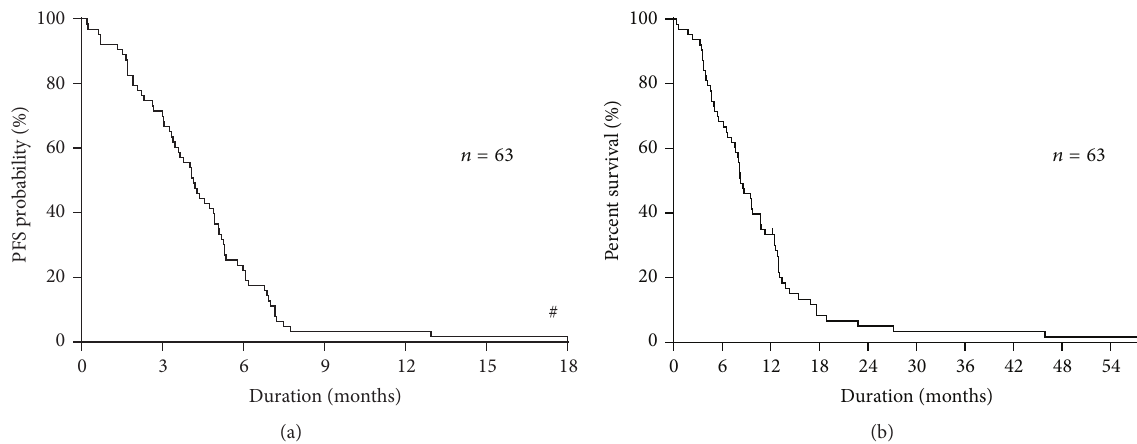
Figure 1: (a) Kaplan-Meier plots showing progression-free survival (PFS). Median progression-free survival: 4.1 months. # Outlier of one case exists. (b) Kaplan-Meier plots showing overall survival (OS). Median overall survival: 8.2 months.